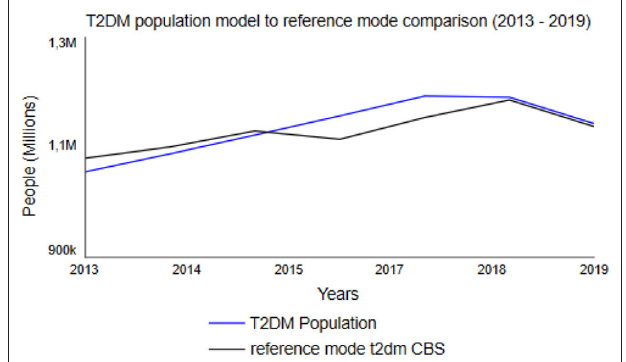
FIGURE 5 | Dutch T2DM Population between 2013 and 2019, based upon Statistics Netherlands (CBS) data (31) as reference mode (black line) and simulated change using the T2DM patient journey model (blue